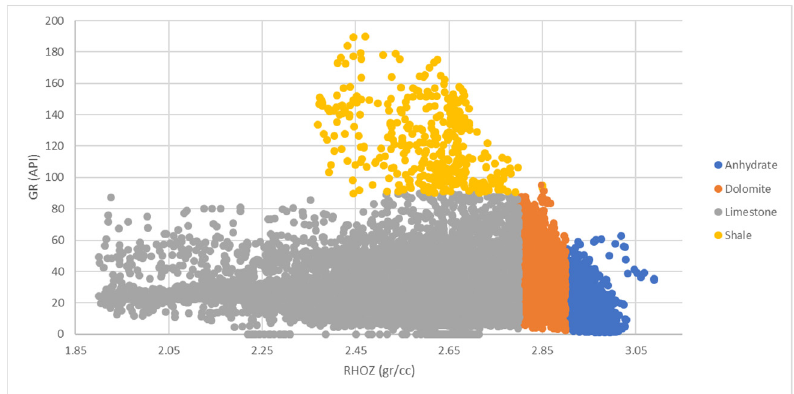
Figure 4. Using cross plot to differentiate between grain and clay supported units.